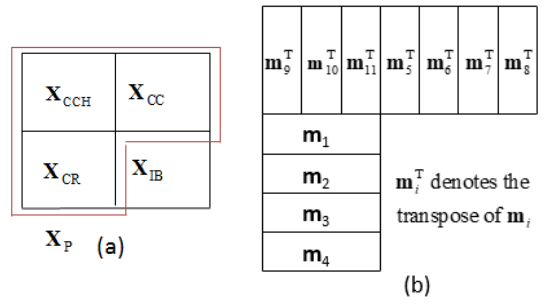
Figure 3. ( a ) X P part of the cover array X ( b ) Secret message block M.